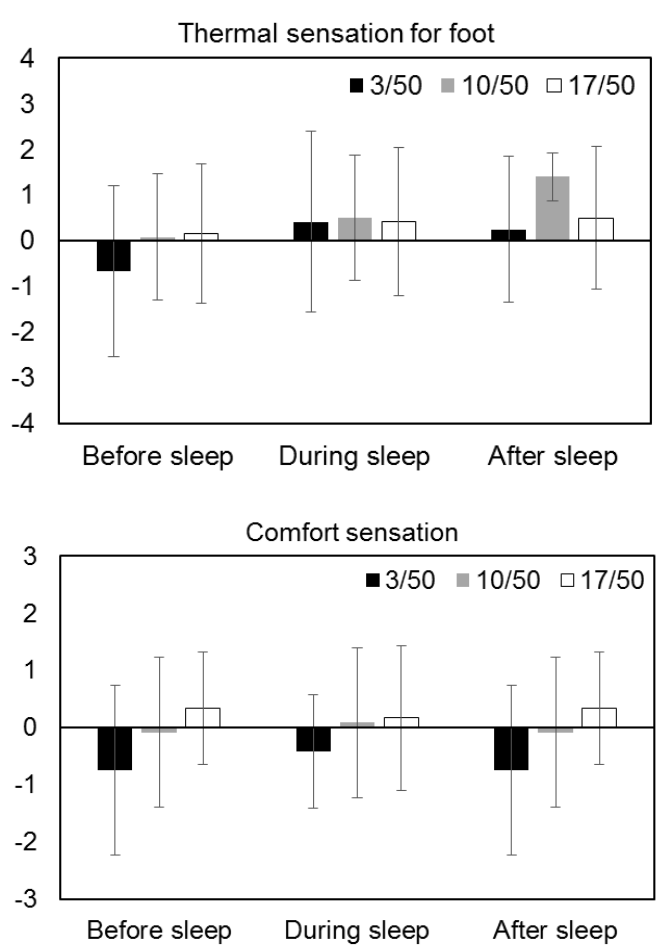
Figure 2. Average (SD) of thermal sensation (TS) and comfort sensation (CS) before, after and during the sleep. TS was asked for the whole body, head and foot, respectively.